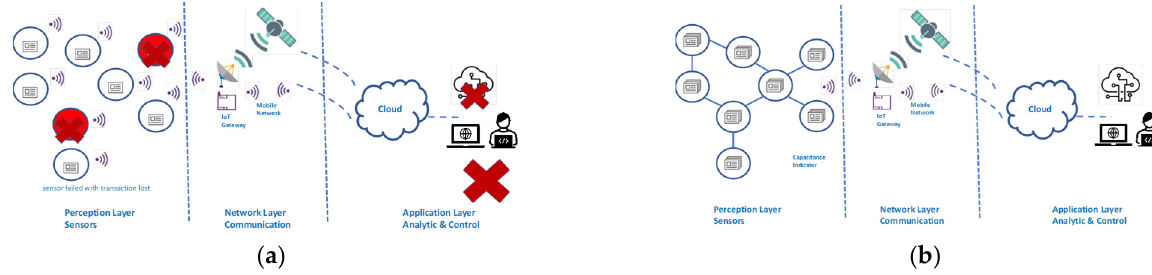
Figure 2. Conventional vs. Blockchain-based IoT architecture with respect to data loss. ( a ) Conventional IoT with potential data loss. ( b ) Blockchain-based IoT without data loss. Table 1. Blockchain generations and main applications.